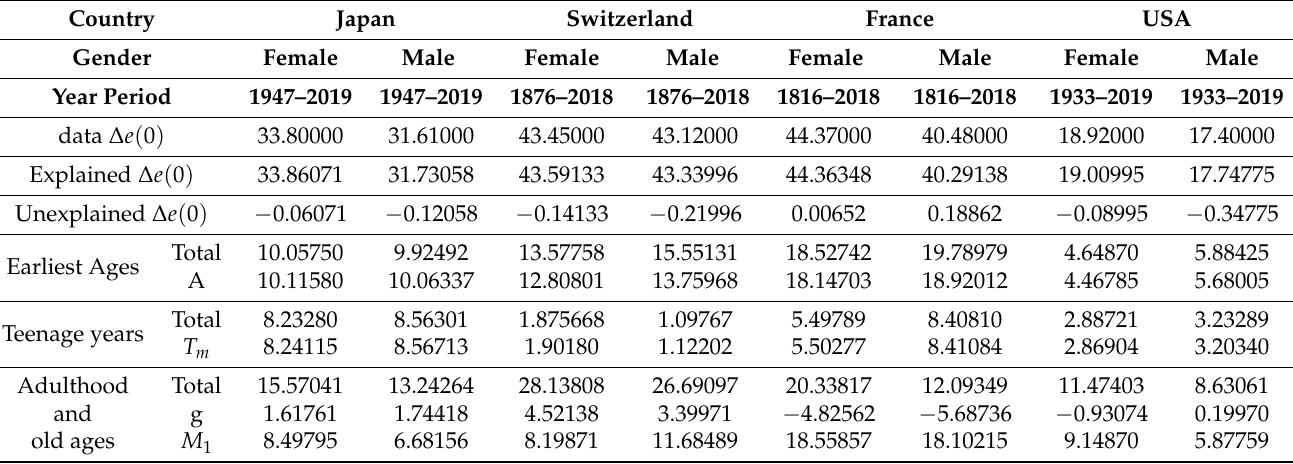
Table 12. Life expectancy improvement quantitative analysis over all available years for 4 HLE countries.